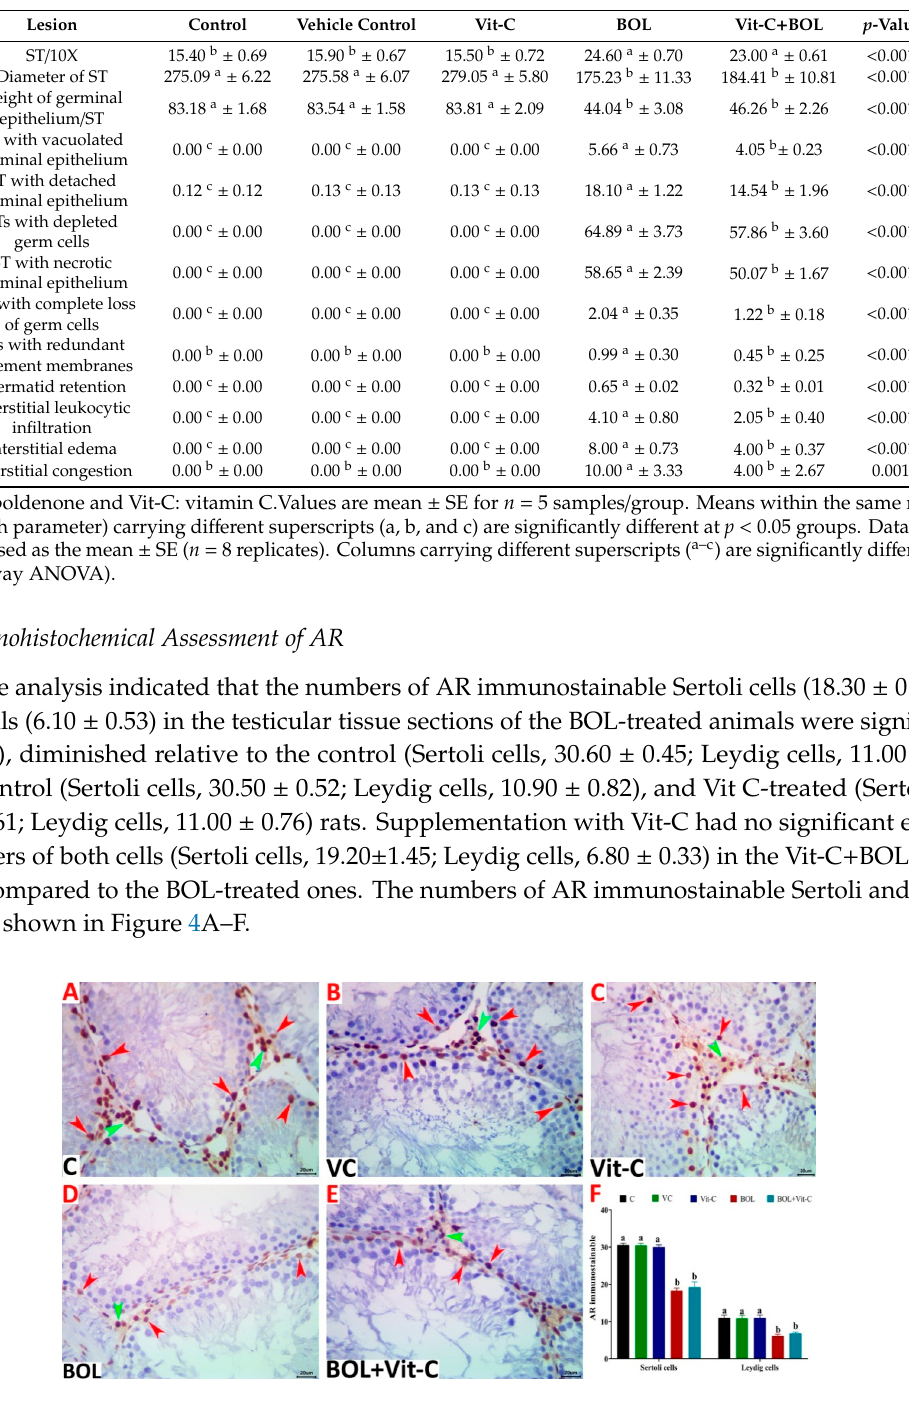
Figure.4. ( A – E ) Representative photomicrograph of testicular tissue sections of androgen receptor (AR) immunoexpression showing a marked decrease in the numbers of AR immunostainable Sertoli (red arrowheads) and Leydig cells (green arrowheads) in control ( A ), vehicle control (VC) of sesame oil ( B ), vitamin C (Vit-C) treated ( C ), boldenone (BOL) treated ( D ), and Vit-C+BOL-treated rats ( E ). The scale bar is 20 microns. ( F ) Changes in numbers of Sertoli and Leydig cells in different experimental groups. Data are expressed as the mean ± SE ( n = 8 replicates). Columns carrying different superscripts (a,b) are significantly different (one-way ANOVA) ( p < 0.001 ).